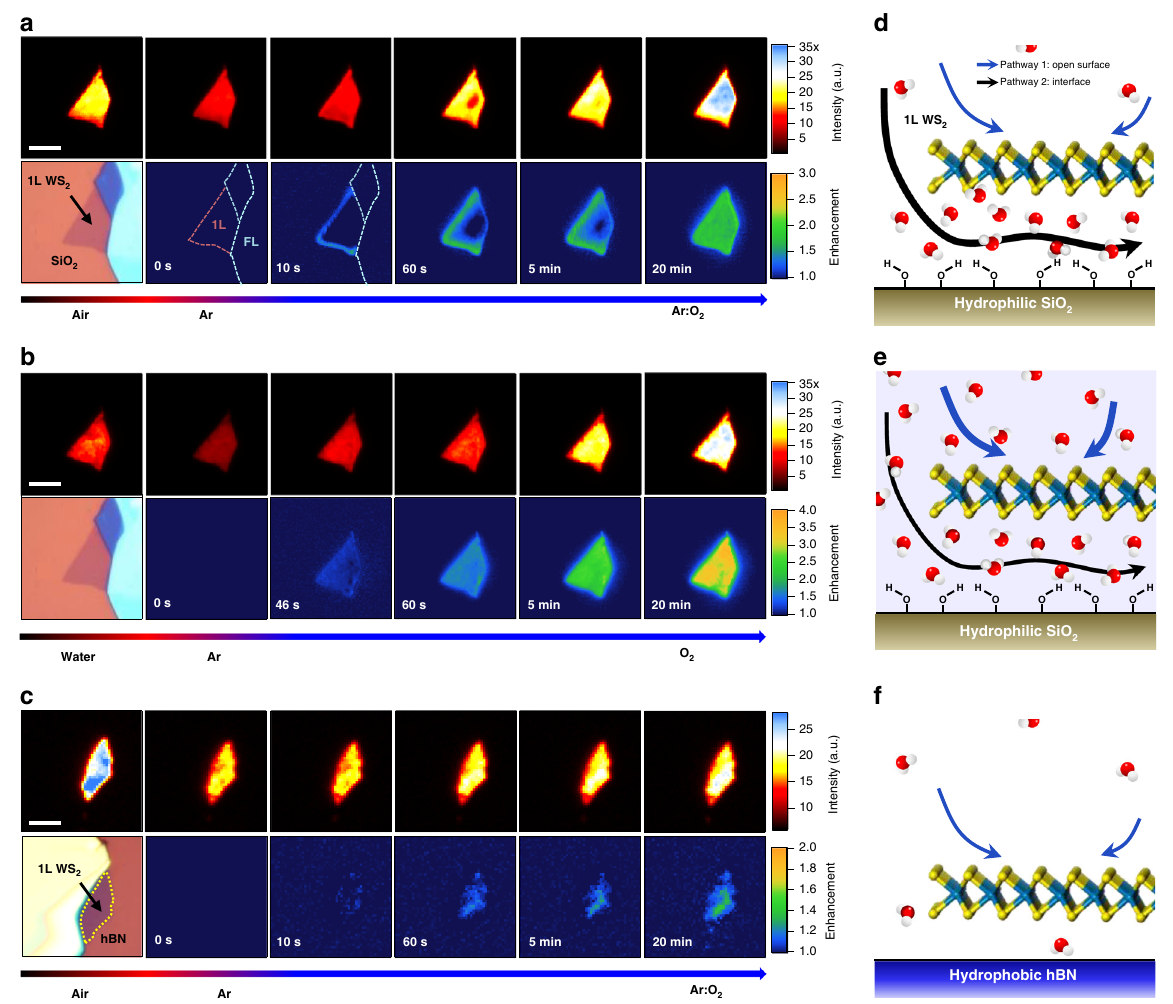
Fig. 2 Real-time photoluminescence images of interface-con fi ned redox reactions. a – c Wide- fi eld PL images (top rows) and optical micrographs followed by PL enhancement images (bottom rows) of 1LW silica in gas ( a ) and water ( b ), and 1LW BN in gas ( c ) environments. Outlines of single and few-layer (FL) areas (dashed lines) were given in the fi rst two enhancement images of ( a ). Exposure time was 1.5 s for each image. The enhancement images were obtained by dividing PL images with those for time zero. Samples in a – c were pre-equilibrated with Ar gas for 2 h before exposure to Ar:O 2 mixed gas (O 2 gas for ( b )) at time zero. For b , gases were bubbled through a sparger immersed in the optical liquid cell. Scale bars: 8 ( a and b ) and 4 ( c ) μ m. d – f Schemes for major diffusion routes of O 2 responsible for redox reactions of 1LW silica in the gas phase ( d ), 1LW silica in water ( e ), and 1LW BN in the gas phase ( f ). The thickness of each arrow represents the relative contribution of each pathway to the overall charge transfer